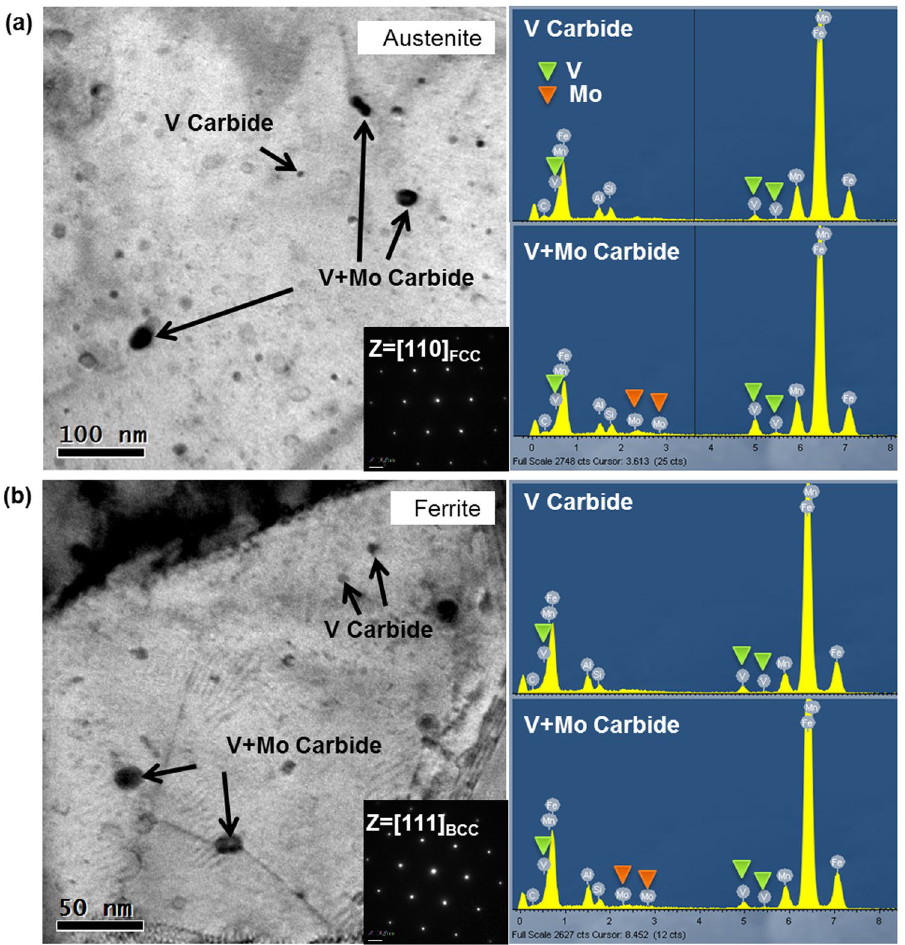
(size; 5~10 nm) have the higher V content, which indicates that they are V carbides. Coarser precipitates (size; ~20 nm) having higher Mo and V contents are identified to be complex (V + Mo)